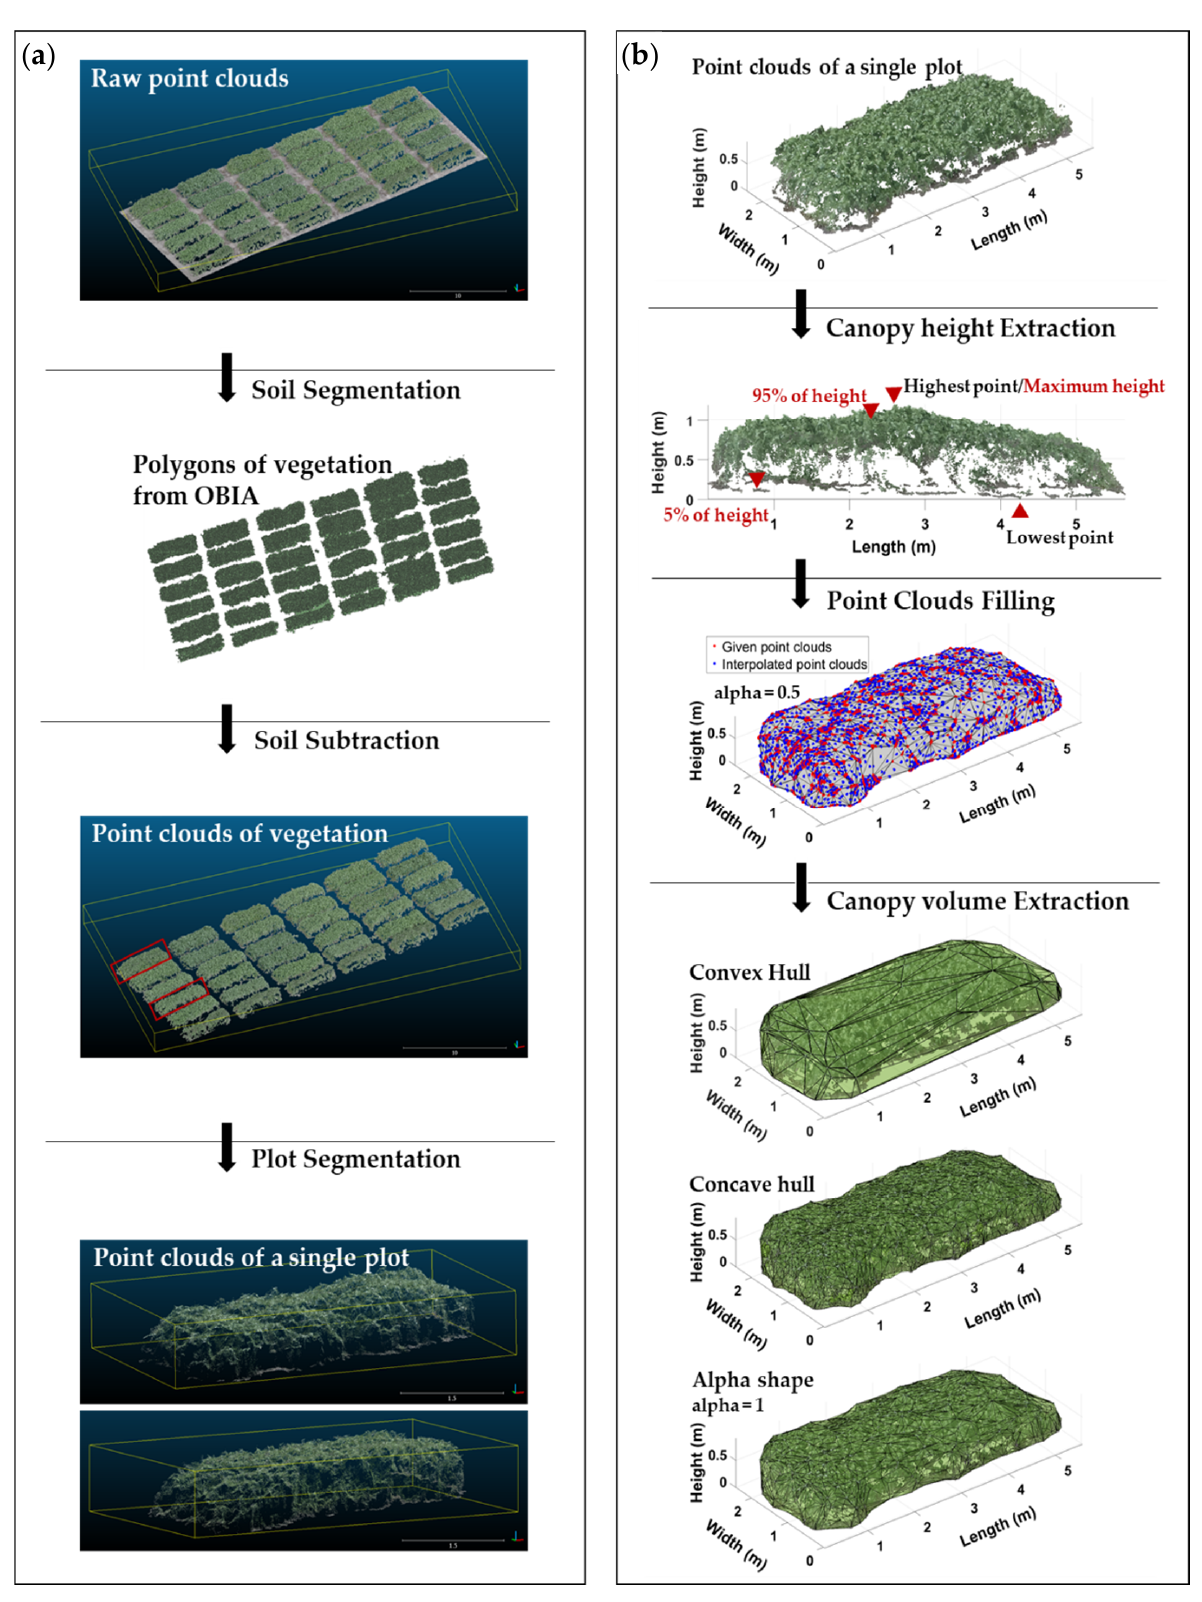
Figure 3. Image processing pipeline for 3D reconstruction model: ( a ) pipeline used to segment the point clouds of an individual winter field pea plot; ( b ) pipeline used to reconstruct 3D models to extract canopy volume.